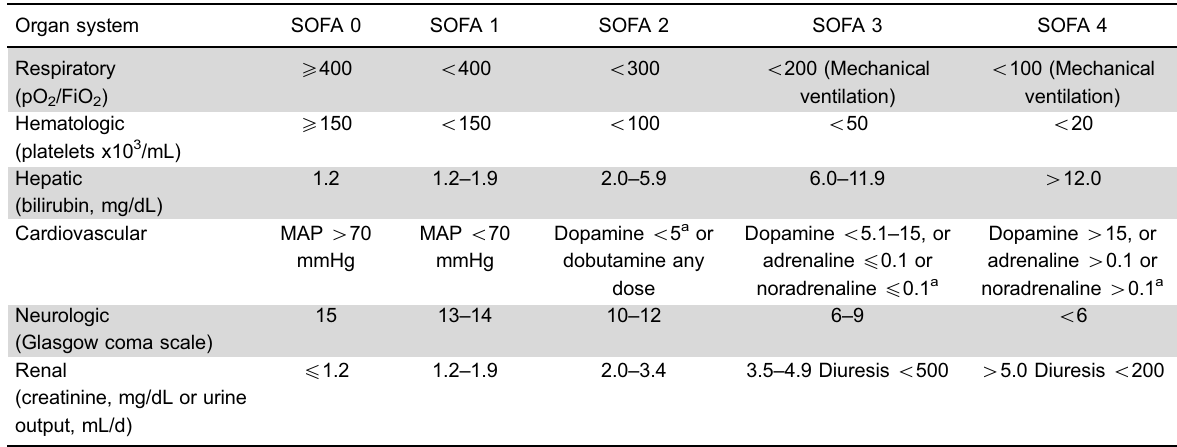
Table 1. Sequential organ failure assessment (SOFA) score. According to Sepsis-3, a variation in SOFA score X 2 in a patient with suspected infection would be diagnosis of sepsis. Organ